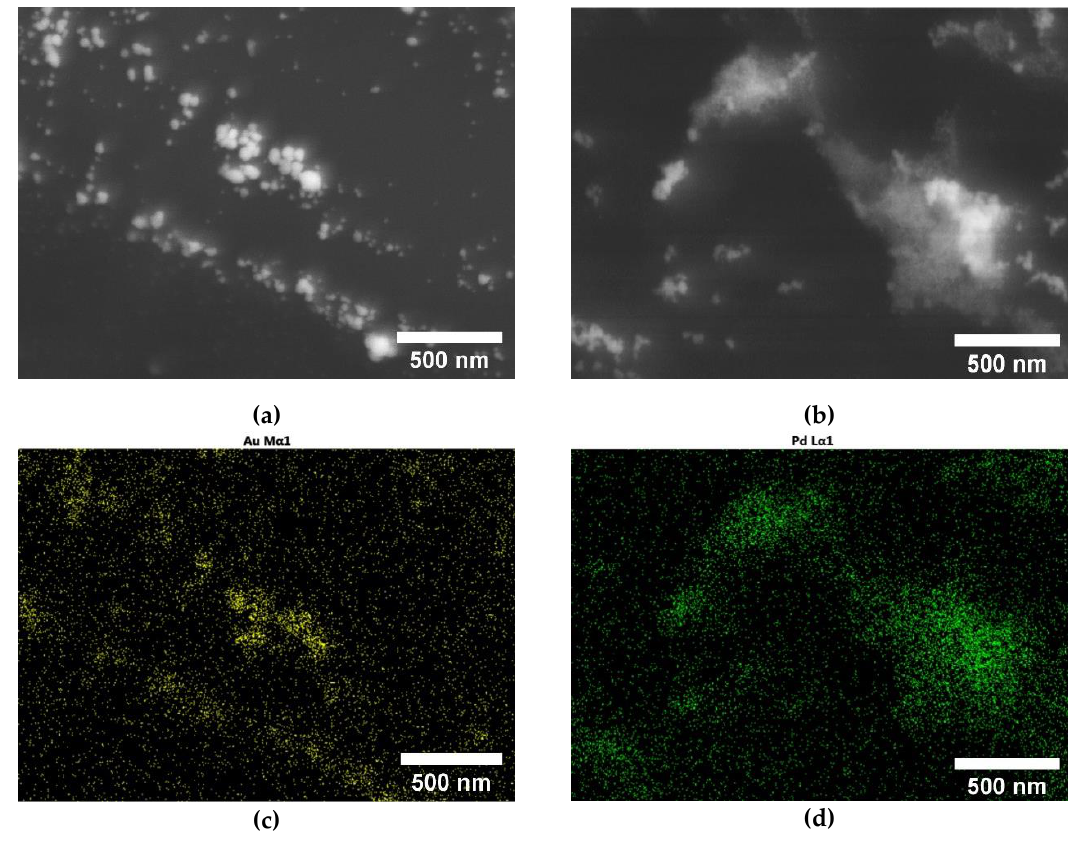
Figure 4. HRSEM micrographs of the struts of the ME/PDMS/Au ( a ) and ME/PDMS/Pd foams ( b ) showing the presence of small nanoparticles (NPs) and aggregates. EDS maps of the micrographs showing of the ME/PDMS/Au (c) and ME/PDMS/Pd ( d ) showing the Au ( c ) or Pd ( d ) signal of the NPs.